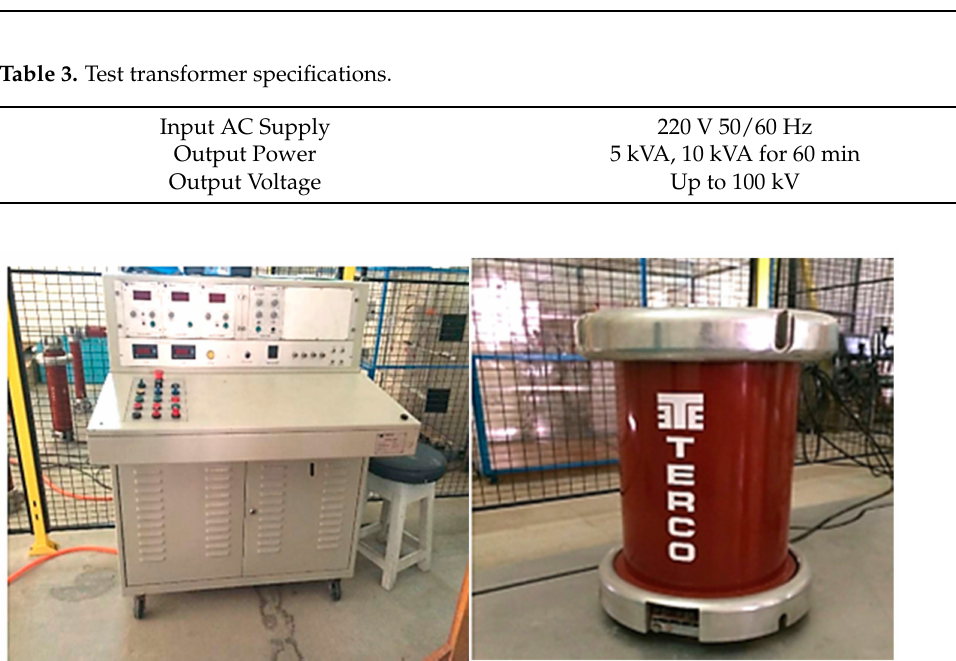
Figure 6. Control desk and test